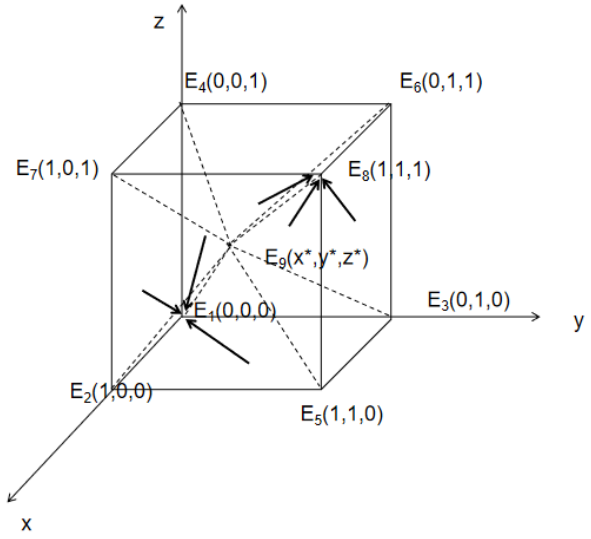
Figure 1. Tripartite main body dynamic evolution trend chart before a Public Health Emergency (About E 9 ). Table 3. The effect of the parameter changes on the action strategy.